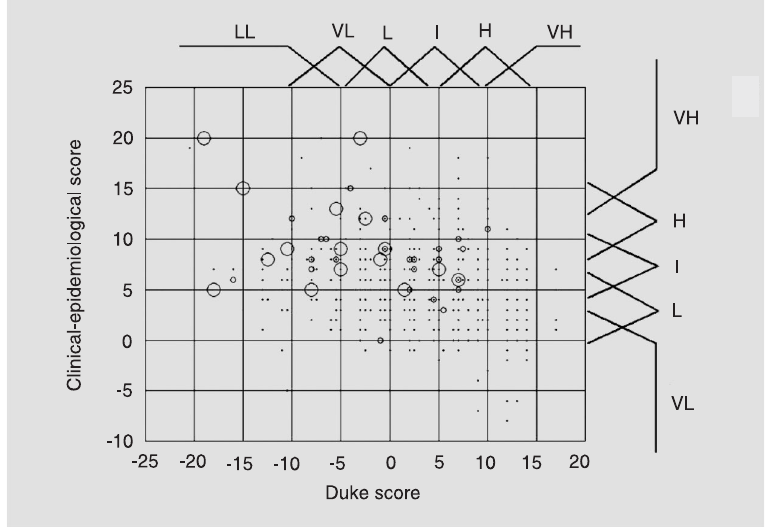
Figure 1. Scatter plot distribution of the results of myocardial perfusion scintigraphy show- ing the fuzzy sets and membership defined by two specialists. The Duke score (x-axis) and clinical-epidemiological score (y-axis) were divided into fuzzy sets: lowest (LL), very low (VL), low (L), intermediate (I), high (H), and very high (VH) (see Table 2). Dot = normal perfusion; small circle = abnormal perfusion without events; large circle = abnormal perfu- sion with events. Events = coronary artery bypass graft surgery or percutaneous transluminal coronary angioplasty.